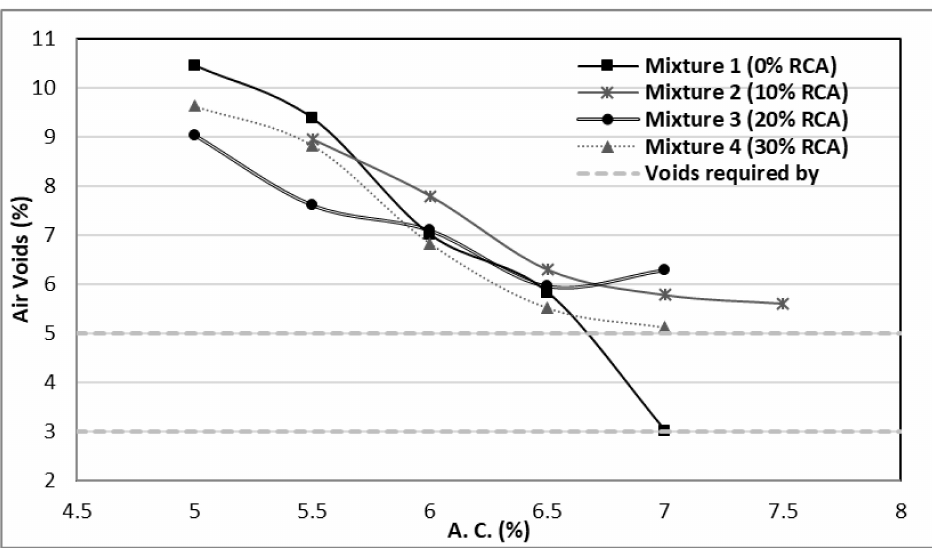
Figure 10. Air voids percentages of the designed mixtures.